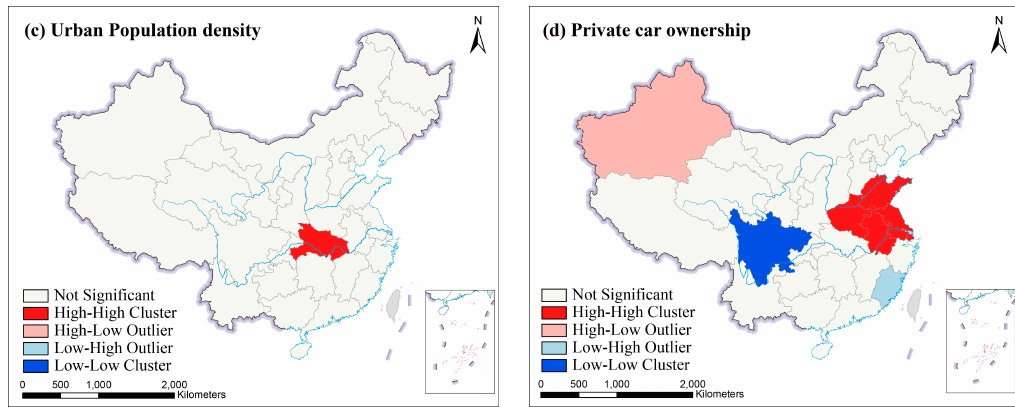
Figure 12. Bivariate cluster maps in Mainland China, in 2016. ( a ) Bivariate cluster map of PM 2.5 concentration and GDPP. ( b ) Bivariate cluster map of PM 2.5 and IVA. ( c ) Bivariate cluster map of PM 2.5 and UPD. ( d ) Bivariate cluster map of PM 2.5 and PCO.